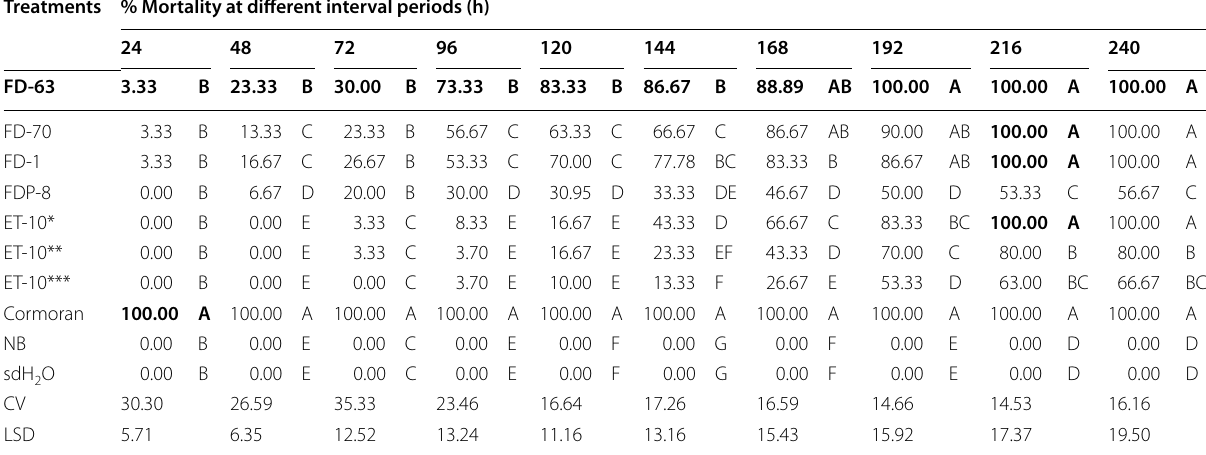
*:1 10 8 conidia/ml consantration, **: 1 ×